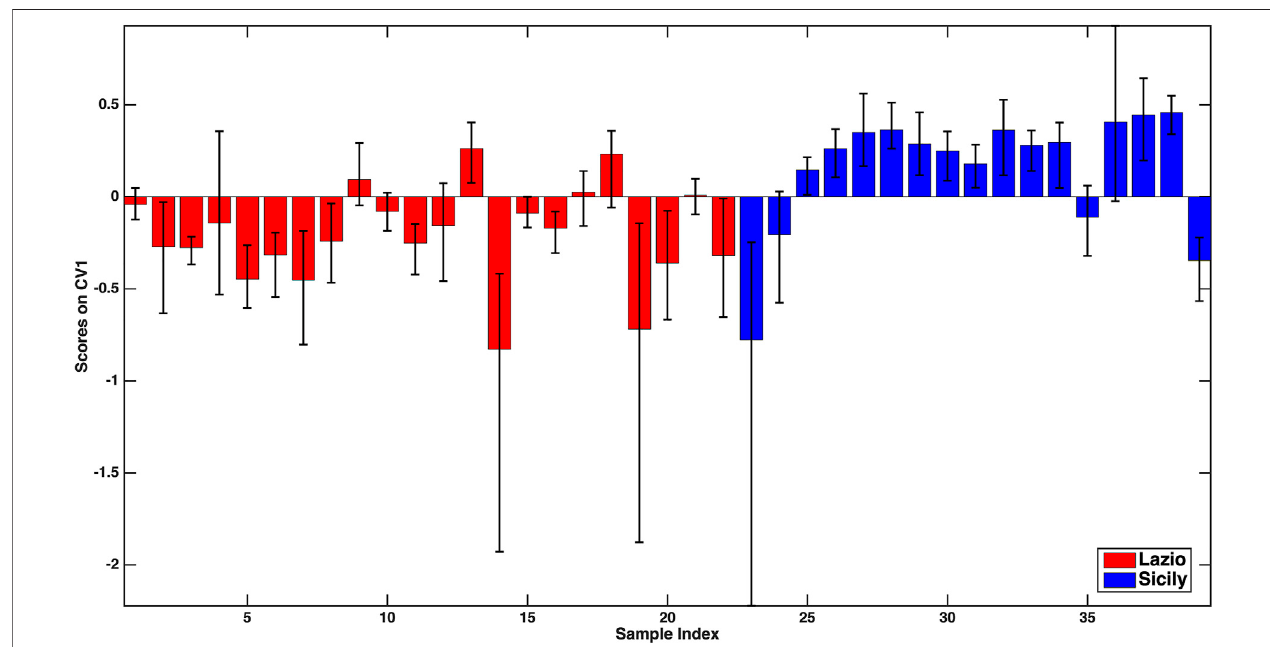
FIGURE2| – PLS-DAmodelforthediscriminationbetweenLazioand Sicilysamples:meanscoresoftherDCVouterloopsamplesalongtheonlycanonical variate of the model together with their 95% con fi dence intervals. Legend: red bars – Lazio; blue bars – Sicily.